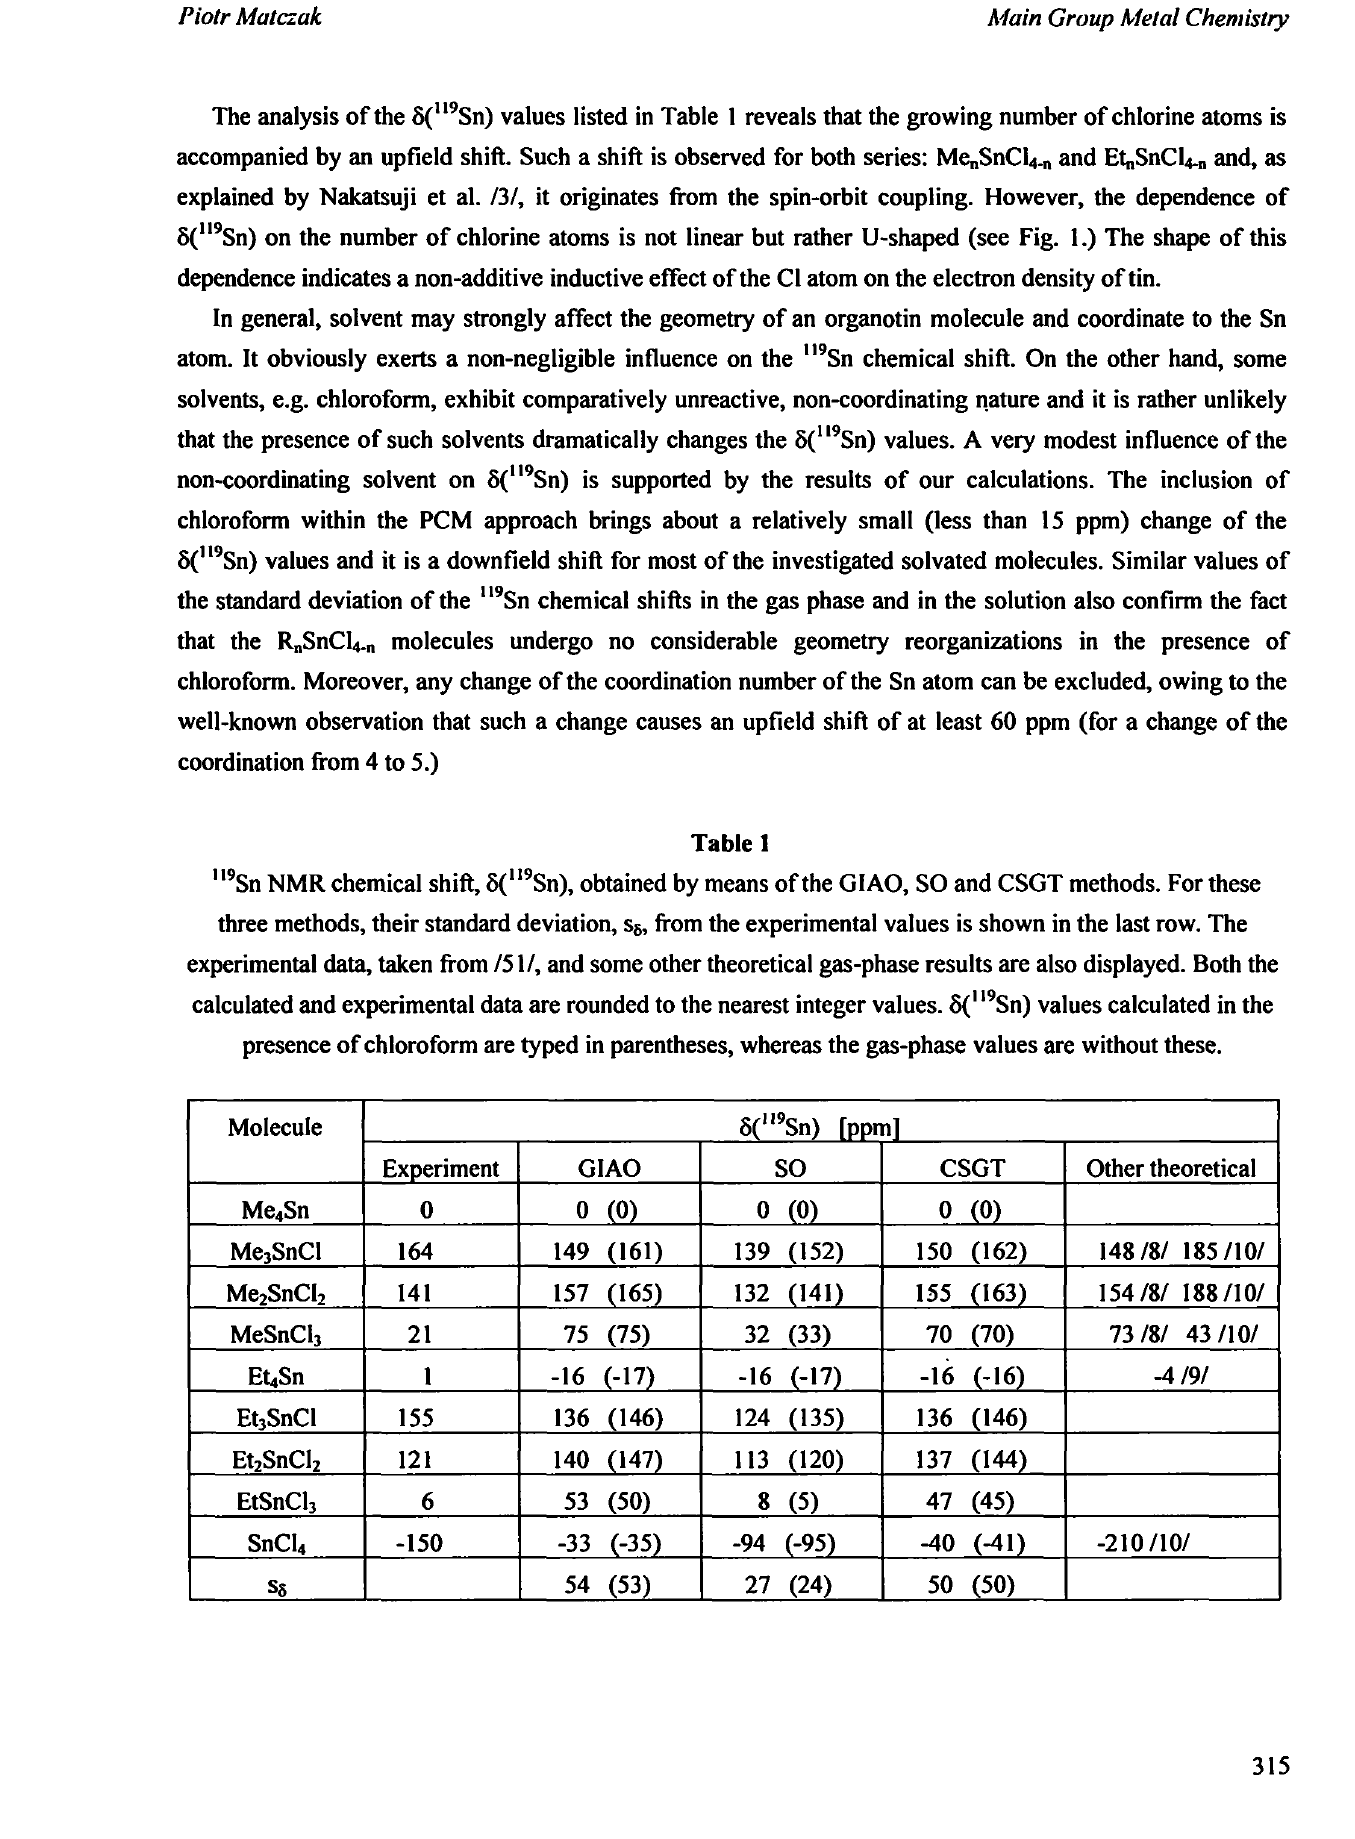
" 9 Sn NMR chemical shift, 5(" 9 Sn), obtained by means of the GIAO, SO and CSGT methods. For these three methods, their standard deviation, s , from the experimental values is shown in the last row. The s experimental data, taken from /51/, and some other theoretical gas-phase results are also displayed. Both the calculated and experimental data are rounded to the nearest integer values. 5(" 9 Sn) values calculated in the presence of chloroform are typed in parentheses, whereas the gas-phase values are without